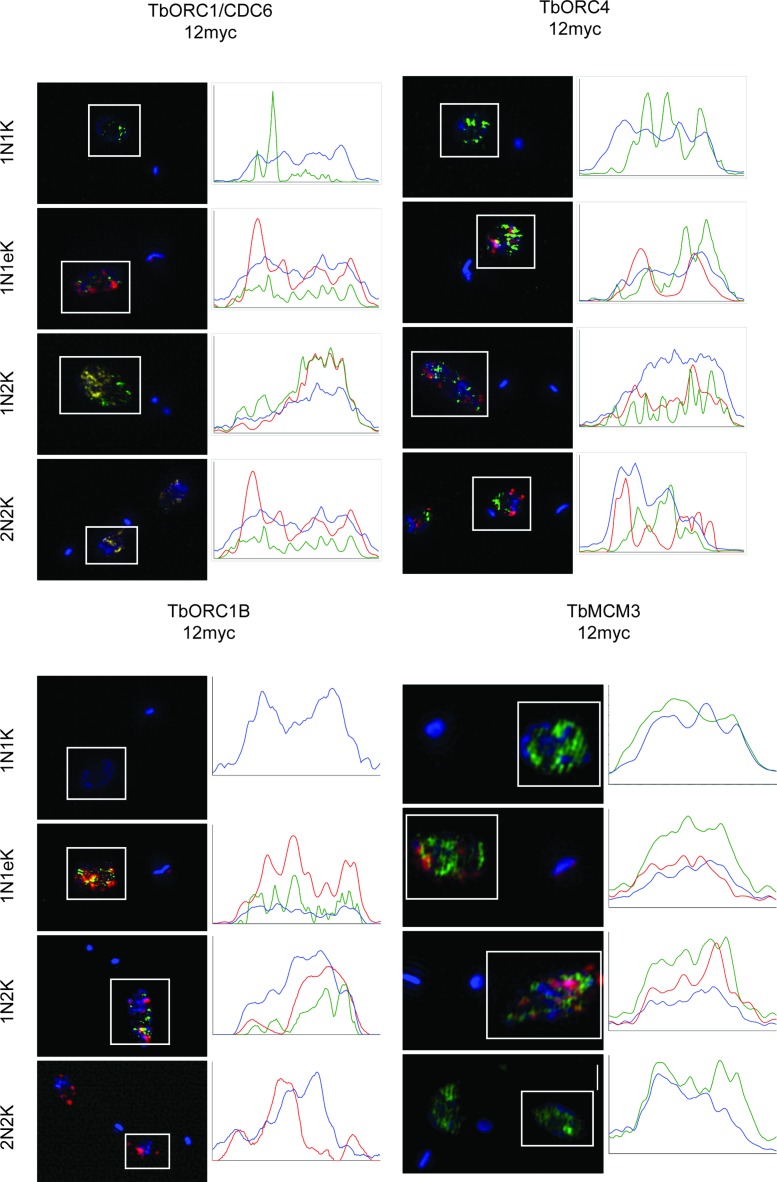
Super-resolution imaging of TbORC1/CDC6, TbORC4, TbORC1B and TbMCM3 through the cell cycle. PCF T. brucei cells expressing TbORC1/CDC6–12myc, TbORC4–12myc, TbORC1B-12myc or TbMCM3–12myc were incubated for 3 h with 150 μm EdU, fixed and stained with DAPI and with AlexaFluor® 488-conjugated anti-myc antibody, while EdU was detected with AlexaFluor® 594-conjugated azide. Images were acquired with a Zeiss Elyra super-resolution microscope system in SIM mode. In each case, representative maximum projection images are shown of cells in the different cell cycle stages, determined by N-K ratio in the DAPI images: 1N1K cells (G1 phase), 1N1eK cells (S phase), 1N2K cells (G2/M phase) and 2N2K cells (post-mitosis). All cells are shown as a merge of the EdU (red), anti-myc antiserum (green) and DAPI (blue) signals, whose intensities are quantified in the plots to the left; signal intensities (y-axes, arbitrary units) were analysed in a horizontal line across the boxed area surrounding the nucleus.